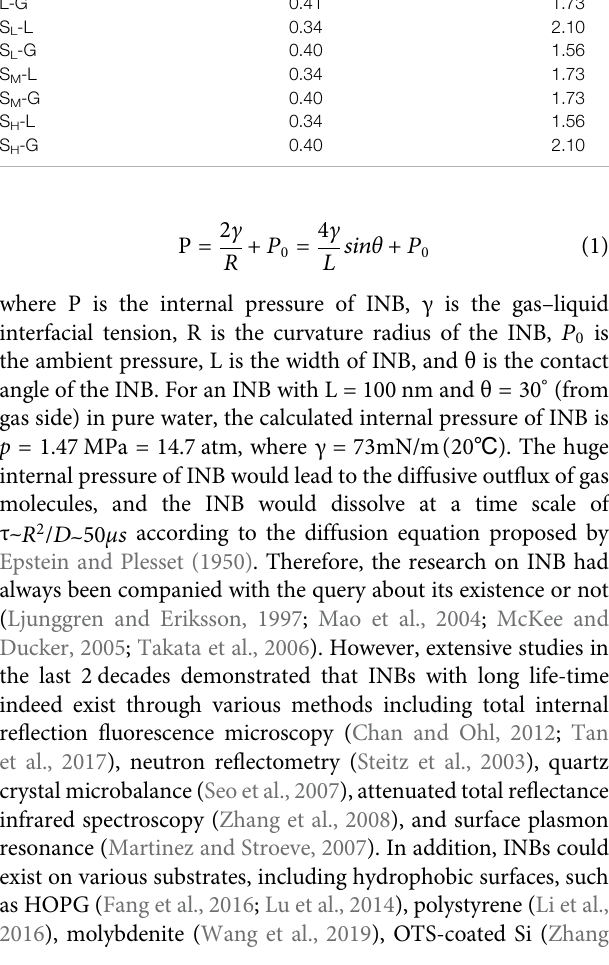
Frontiers in Materials |